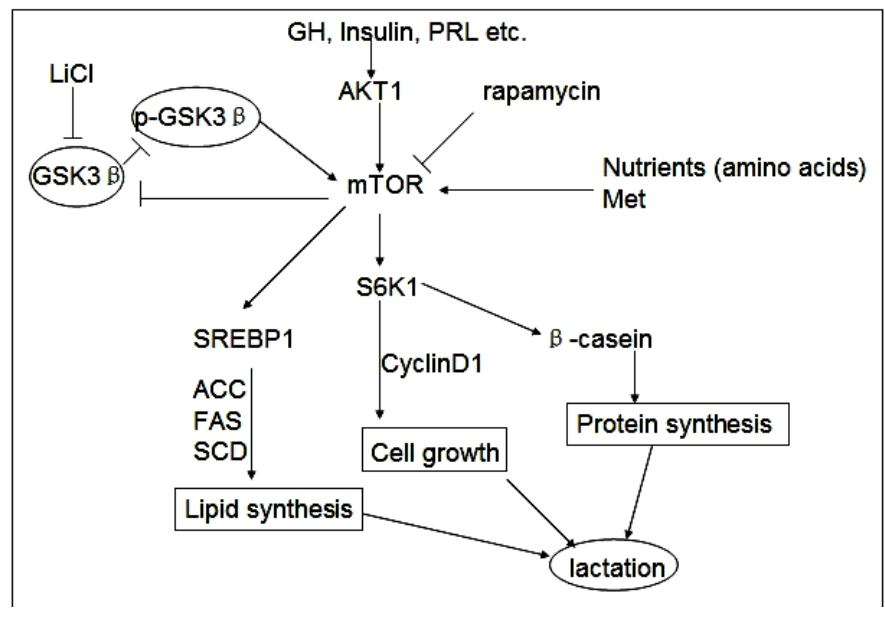
Figure 5. GSK3 β and phospho-GSK3 β regulate milk synthesis and DCMEC